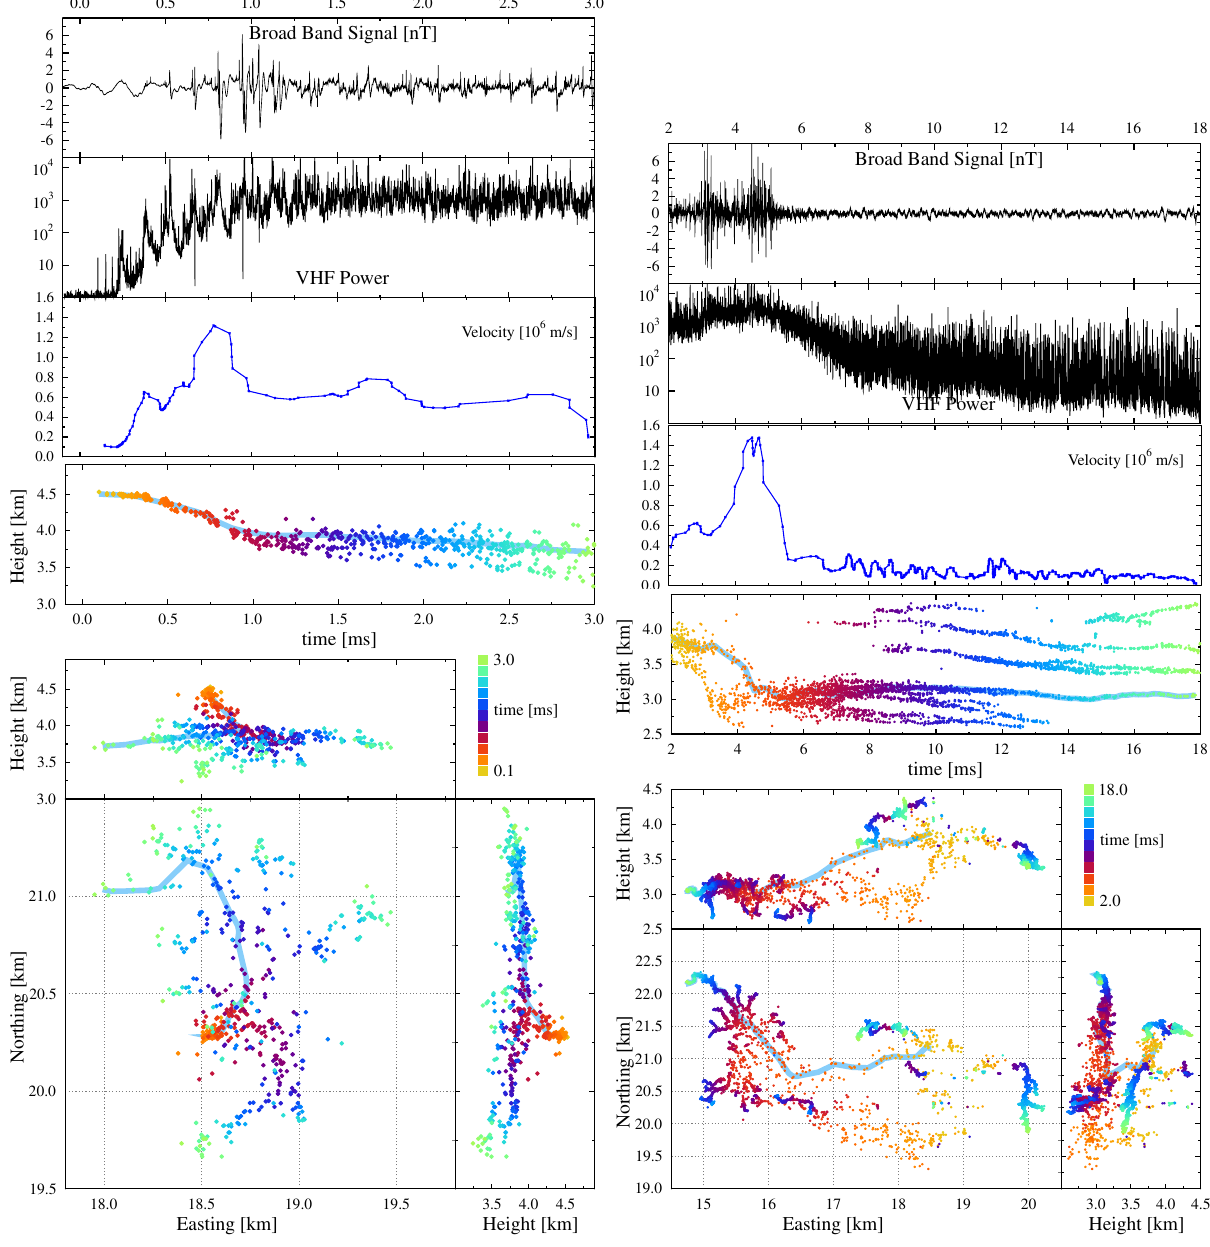
Figure 3. Similar to Fig. 1 with an added panel (third from the top) showing the propagation velocity along the track indicated in light blue in the lower panels. The power recorded at a core station of LOFAR is now re-binned over 2 µ s. The left (right) side pertains to the sources for the first 3 ms (2–18 ms) for Flash A,